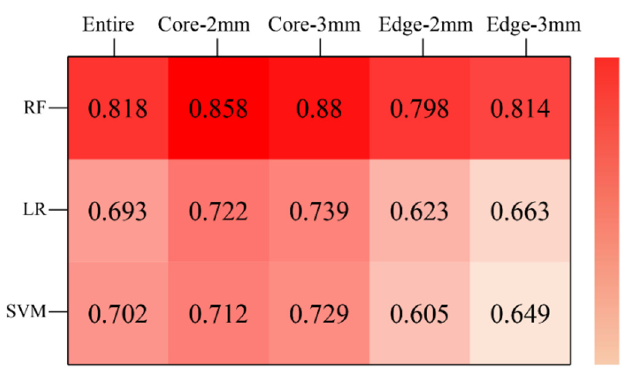
Figure 7. The heatmap of AUCs of three classifiers constructed with five different VOIs. Darker colors mean higher AUC values. AUC, area under the curve; RF, random forests; LR, logistic regression; SVM, support vector machines.